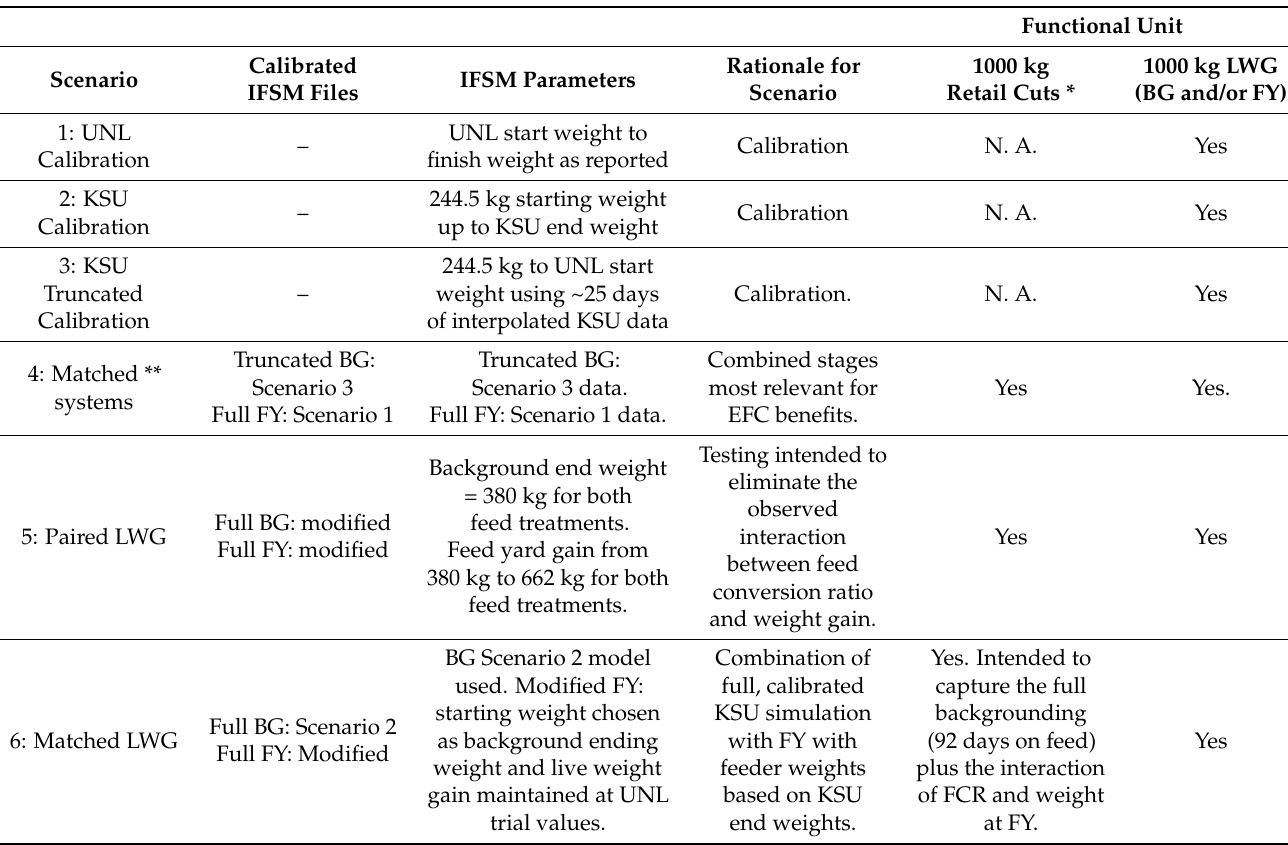
Table 1. Scenarios analyzed in the LCA comparing conventional corn and Enogen corn feed component efficiencies and impacts on